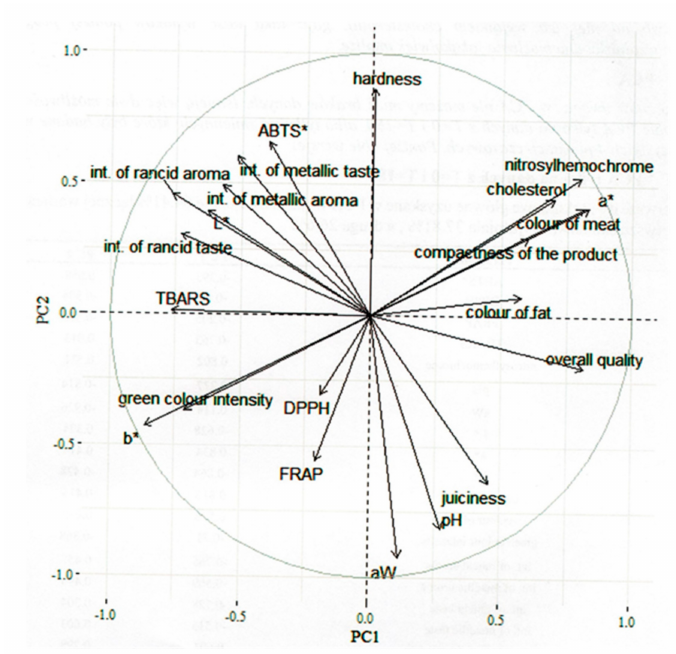
Figure 2. The variables factor map